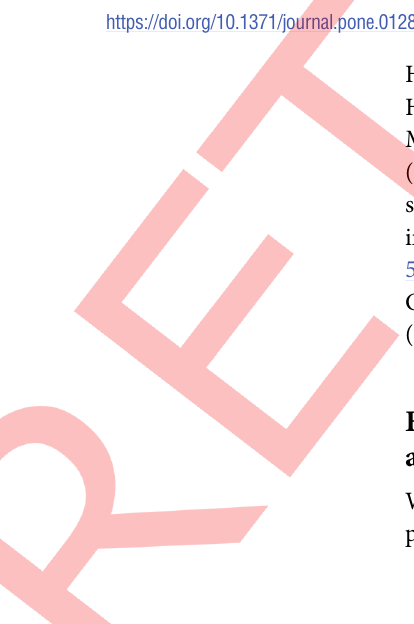
PLOS ONE | https://doi.org/10.1371/journal.pone.0128648 June 22,